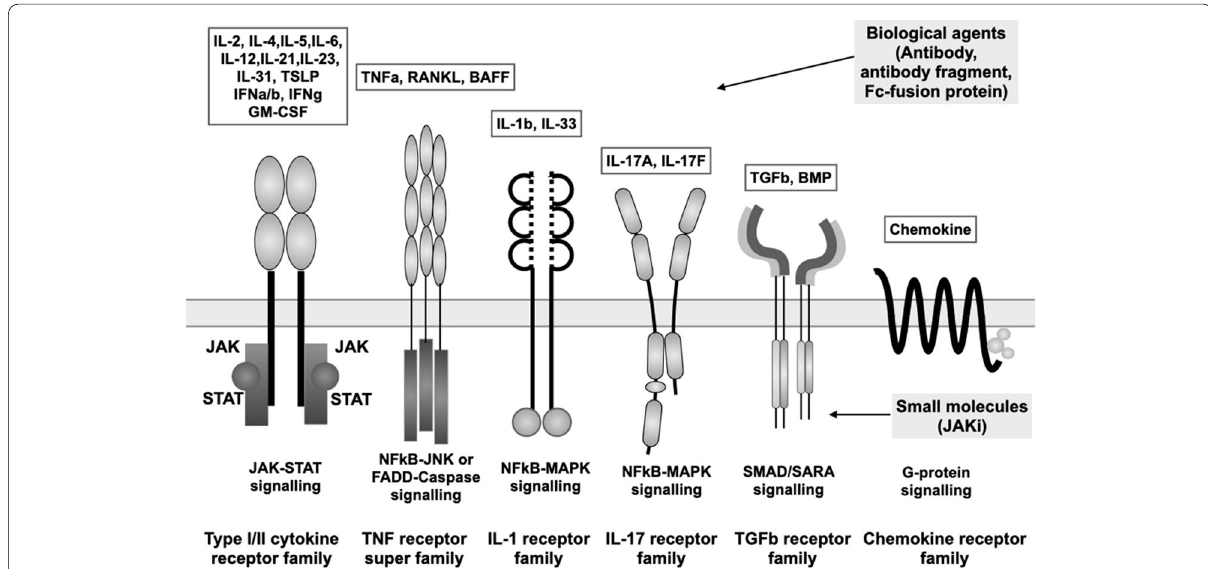
Fig. 1 Cytokines and cytokine receptor families involved in immune-mediated diseases. White boxes in the top part of the figure list the cytokines implicated in IMID, which bind the cytokine receptors schematically depicted below. Horizontal gray bar represents the cell membrane. Under the cell membrane, signaling systems located downstream of the cytokine receptors are indicated. Gray boxes on the right list biological agents located outside the cells (top) and JAK inhibitors located inside the cells